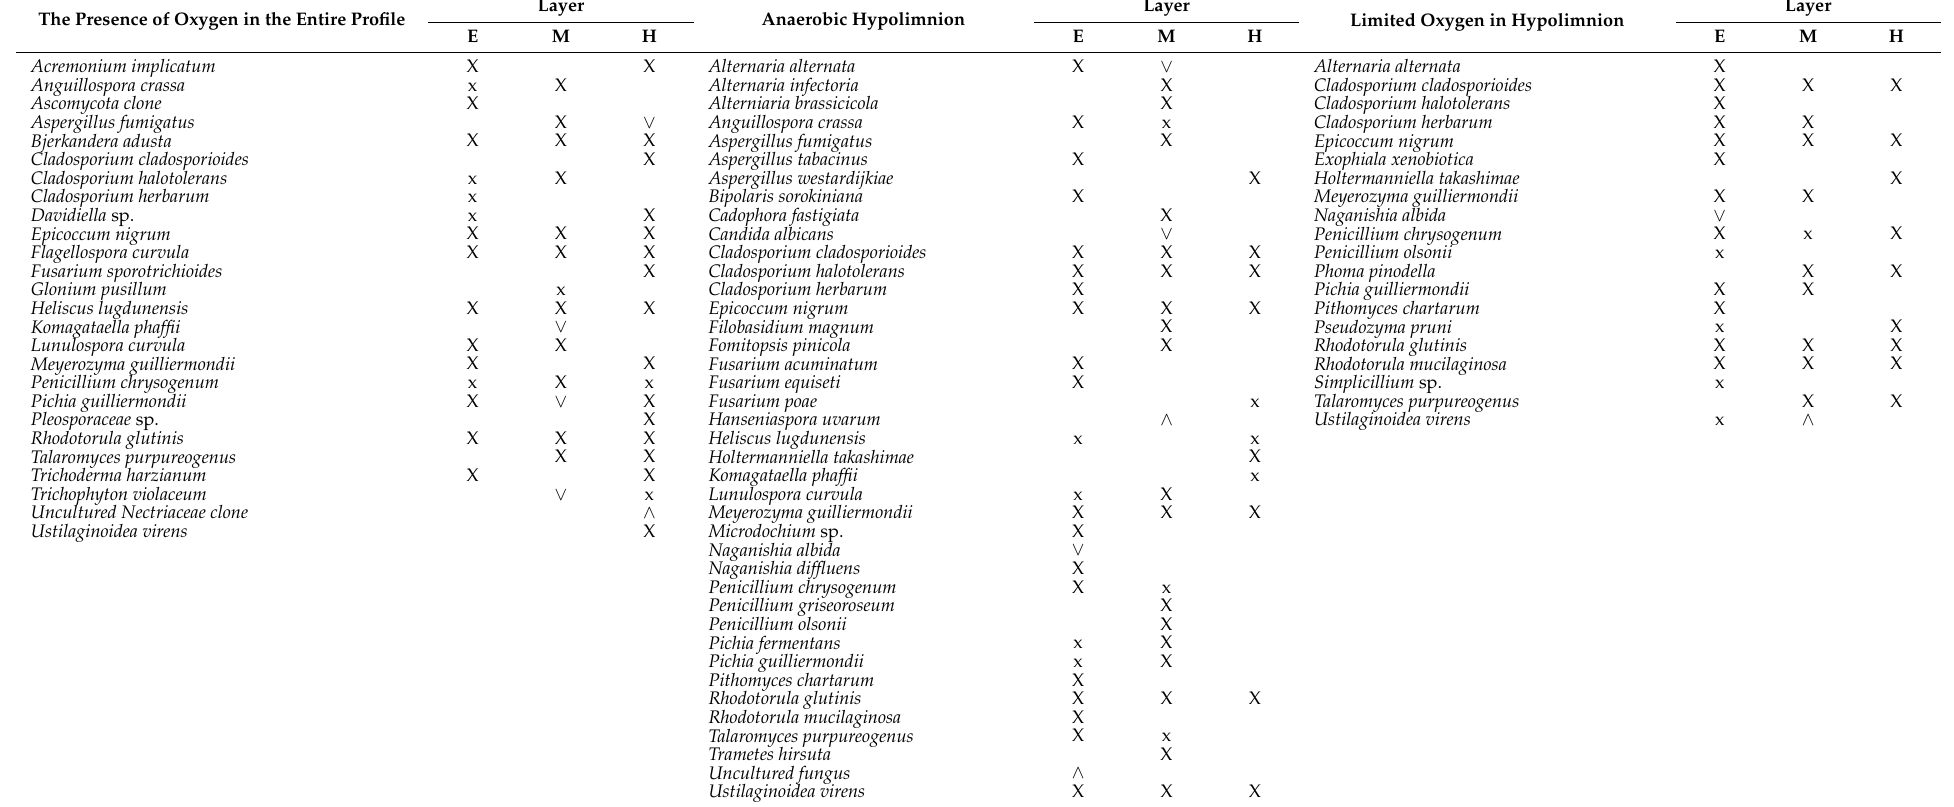
Table 4. Species diversity of mycoplankton in mesotrophic lake profiles depending on oxygen availability. X—species appearing in 5 out of 5 examined lakes, x—species appearing in 4 out of 5 examined lakes, ∨ —species appearing 3 out of 5 lakes, ∧ —species appearing 1 out of 5 lakes